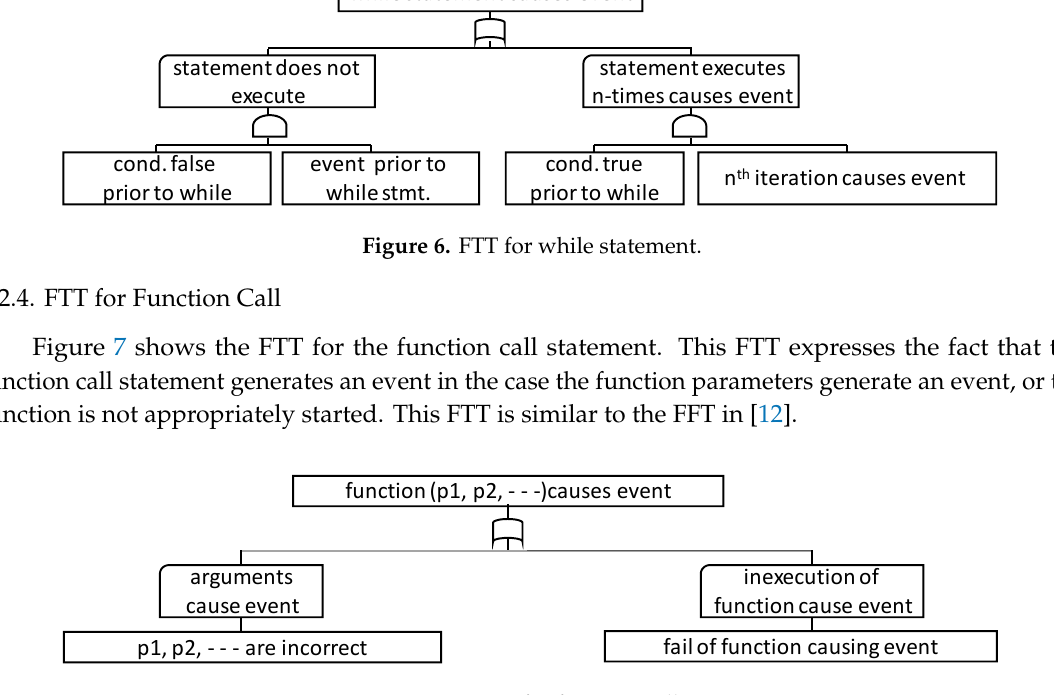
Figure 7. FTT for function call.